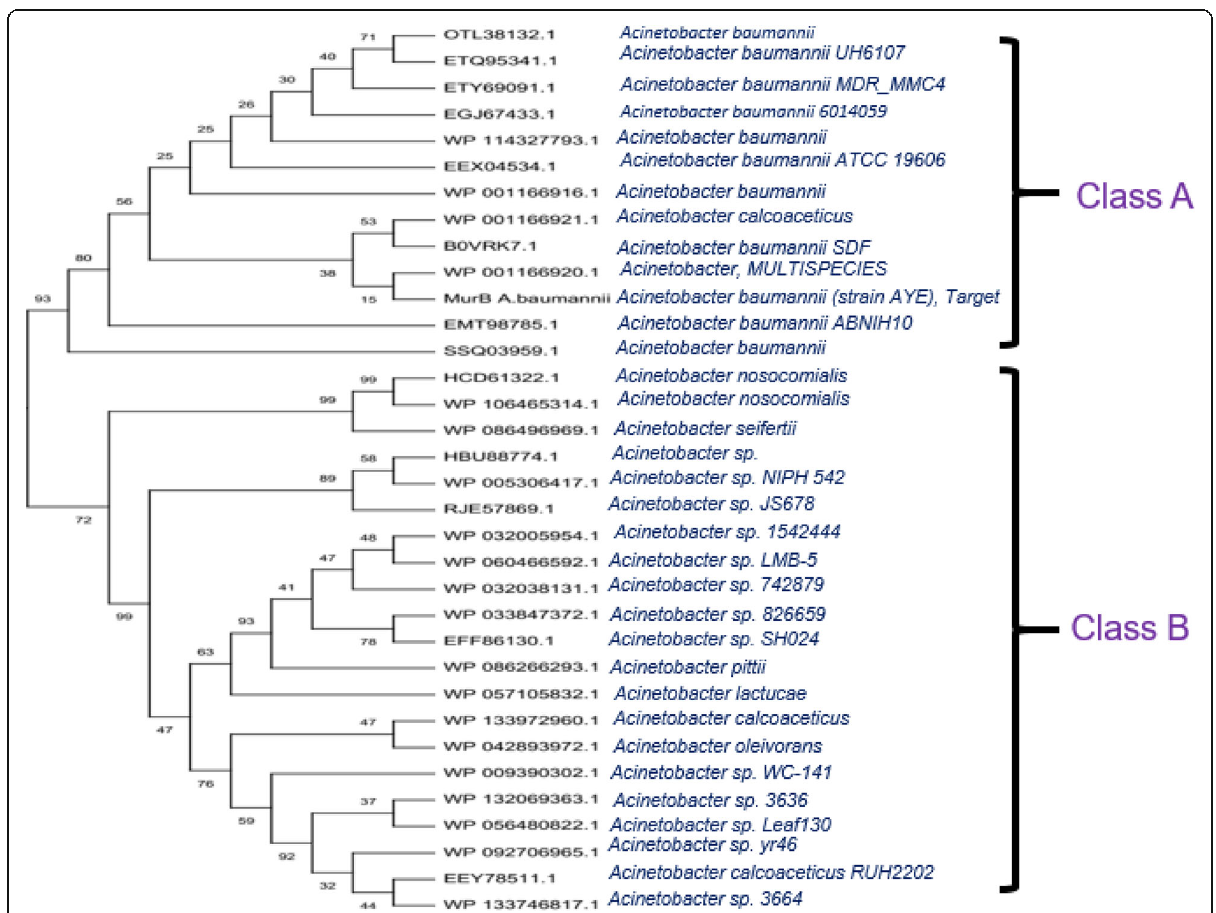
Fig. 4 Phylogenetic tree construction of MurB from A . baumannii with related sequences. The tree was prepared by neighbor-joining method. For the clarity, part of the tree was presented